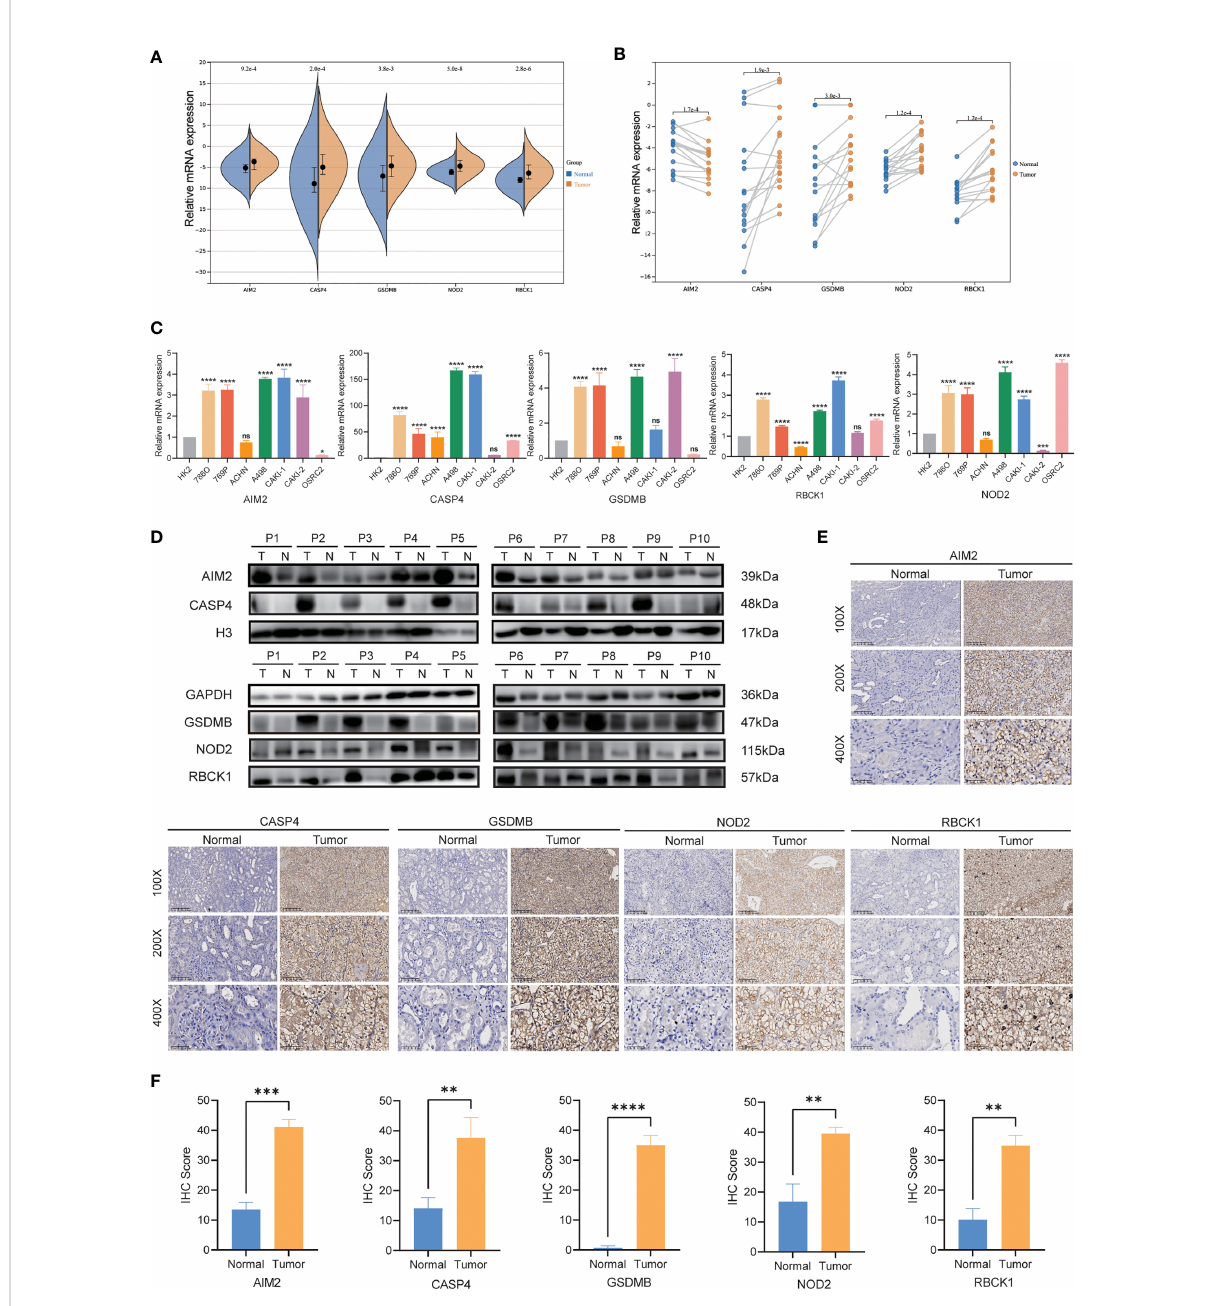
FIGURE 9 qRT-PCR, IHC and WB veri fi cation. (A, B) mRNA expression of AIM2, CASP4, GSDMB, NOD2 , and RBCK1 in ccRCC patients by qRT-PCR. (C) Levels of the mRNA expression in different cell lines as assessed by qRT-PCR analysis. (D) Protein expression of AIM2, CASP4, GSDMB, NOD2 , and RBCK1 in ccRCC patients by Western blot. (E, F) Expression of AIM2, CASP4, GSDMB, NOD2 , and RBCK1 makers in ccRCC tumor tissue and normal tissues by IHC. *P < 0.05; ** P < 0.01; *** P< 0.001; **** P< 0.001; ns, no signi fi